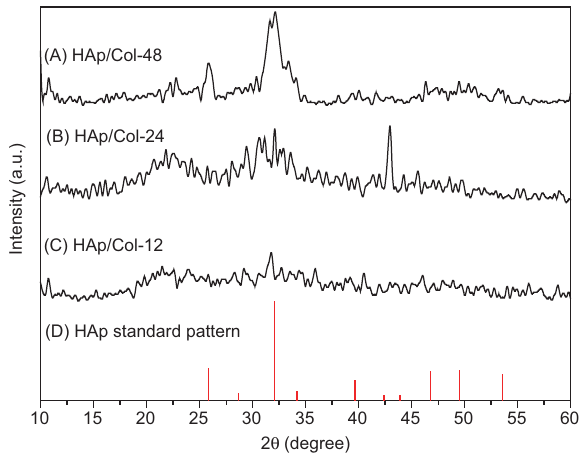
Figure 1 XRD patterns of HAp/Col composites with varied